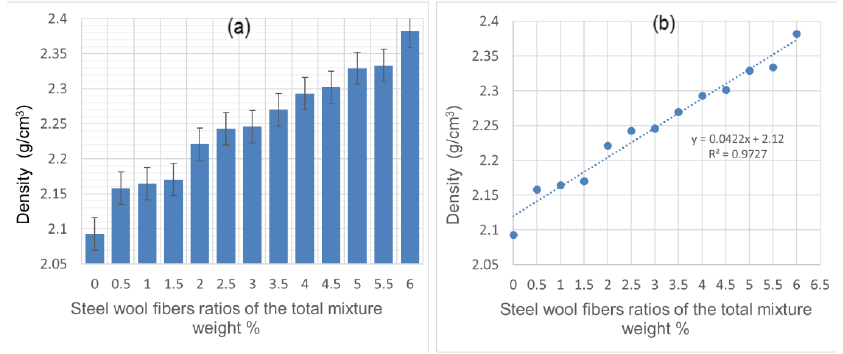
Figure 3. The density of cement mortar for various ratios of CSWFs: ( a ) density values of the composite matrix corresponding to the CSWF ratios, ( b ) correlation between density and CSWF addition.